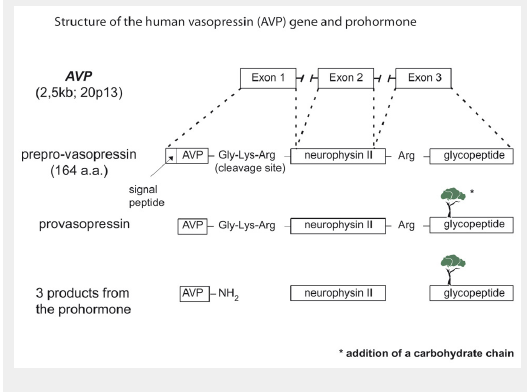
Schematic representation of the relationship between plasma vasopressin and plasma osmolality in the presence of differing states of blood volume and/or pressure. The line labelled N represents normovolaemic normotensive conditions. Minus numbers to the left indicate percent fall, and positive numbers to the right, percent rise in blood volume or pressure.